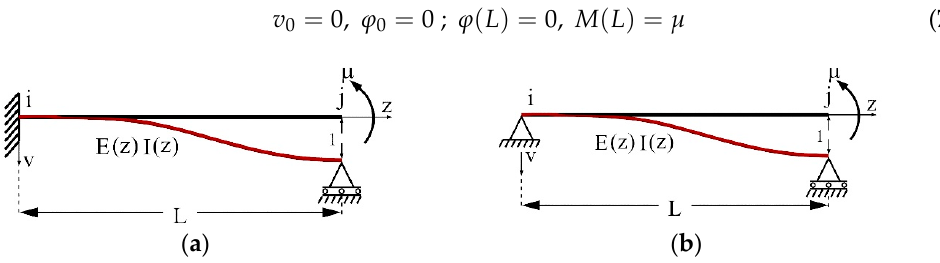
Figure 11. ( a ) Vertical displacement occurs at the j -end of the beam owing to the moment µ ; ( b ) vertical displacement occurs at the j -end of the beam owing to the moment µ